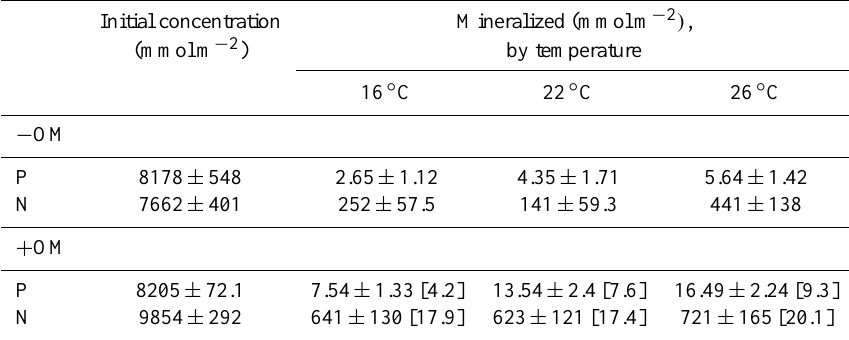
Table 1. Depth-integrated (0–16cm) pools of P and N (mean ± SE) in the sediment used in the experiment ( n = 3, initial concentration) and the estimates of the amount of nutrient mineralized during the experiment based on nutrient sediment–water-column fluxes ( n = 6). Values in square brackets indicate the percentage of the nutrient mineralized out of the total